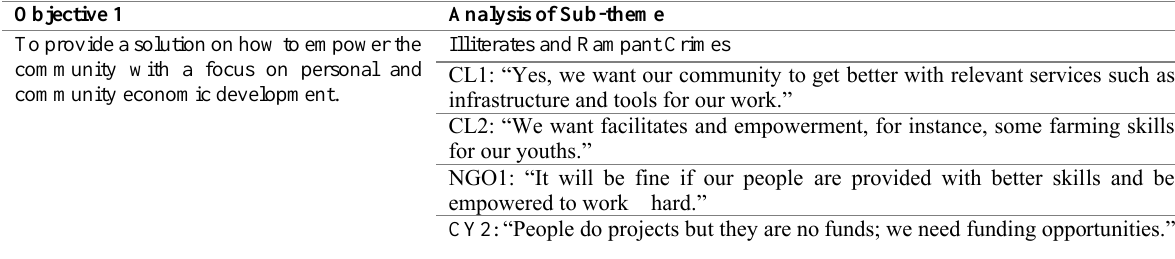
Table 3: Thematic representation of data based on the research objective